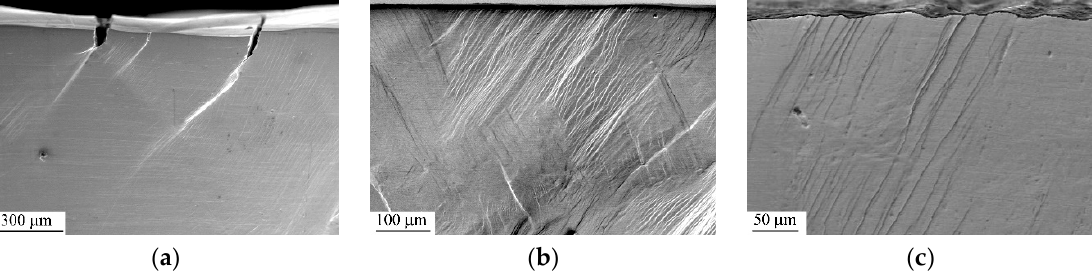
Figure 16. Cross-sectional SEM images of as-built ( a ), mechanically polished ( b ), or electron beam